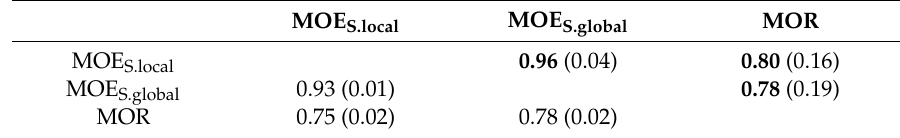
Table 4. Additive genetic ( r A , above diagonal) and phenotypic ( r P , below diagonal) correlations among destructively measured variables (standard errors in parentheses).